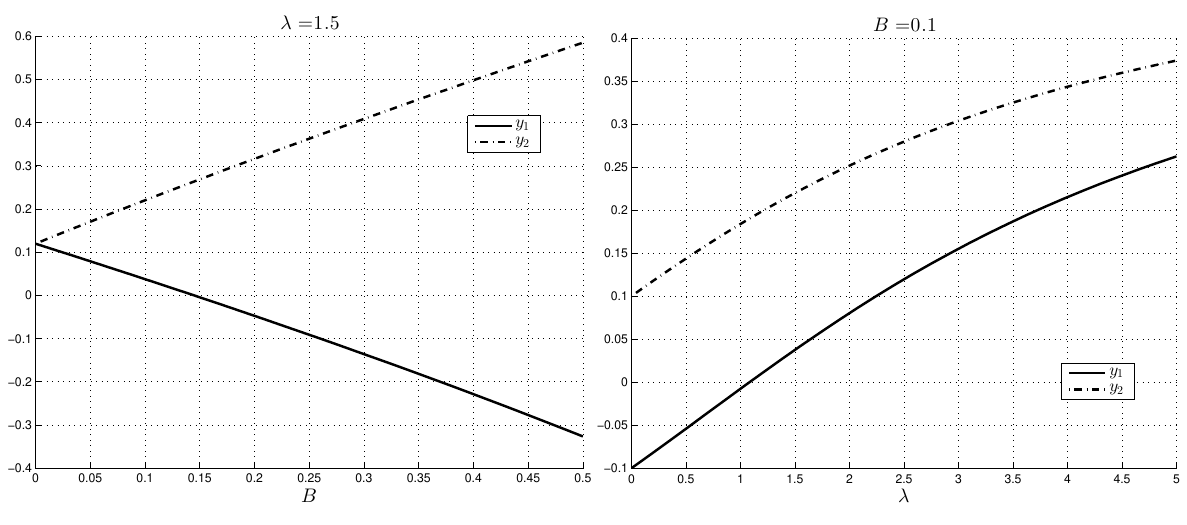
Figure 7. Case 1 : plug boundaries ( y 1 , y 2 ).